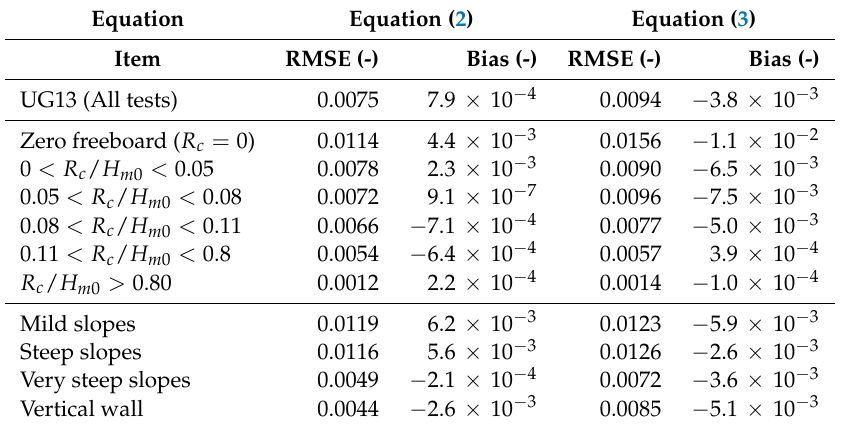
Table 6. RMSE values (Equation (9)) and bias (Equation (10)) of the UG13 dataset in different ranges of relative crest freeboards R c / H m 0 and slope angle α